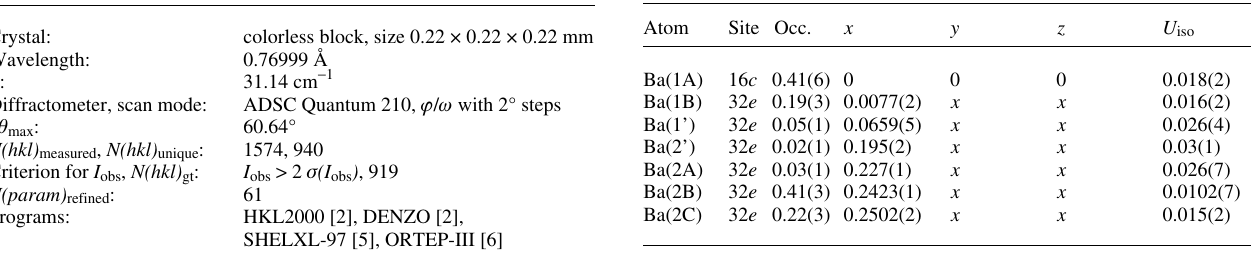
Table 1. Data collection and handling. Table 2. Atomic coordinates and displacement parameters (in Å 2 )